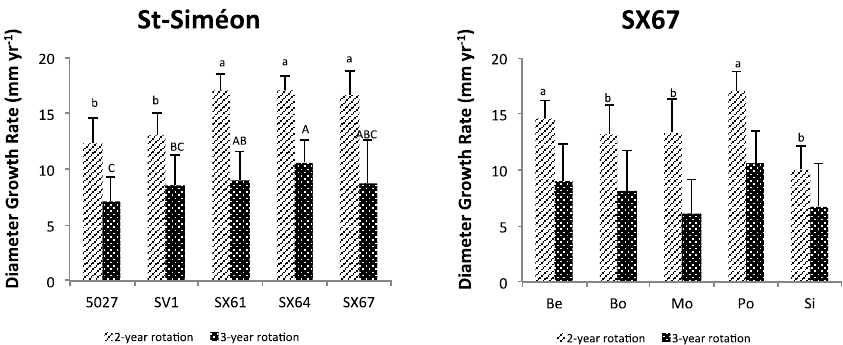
Figure 2. Stem diameter growth rates of willow stems under different rotation cycles. Values are means ( n = 9; standard deviation on the top of each bar) for each site (Be = Beloeil; Bo = Boisbriand; Mo = La Morandière; Po = La Pocatière, Si = St-Siméon) and cultivar. A 5% significance level was adopted for identifying significant treatment effects according to Tukey’s HDS test. Lowercase letters were used to highlight significant difference in two-year rotation. Capital letters identify significant differences in the three-year rotation.